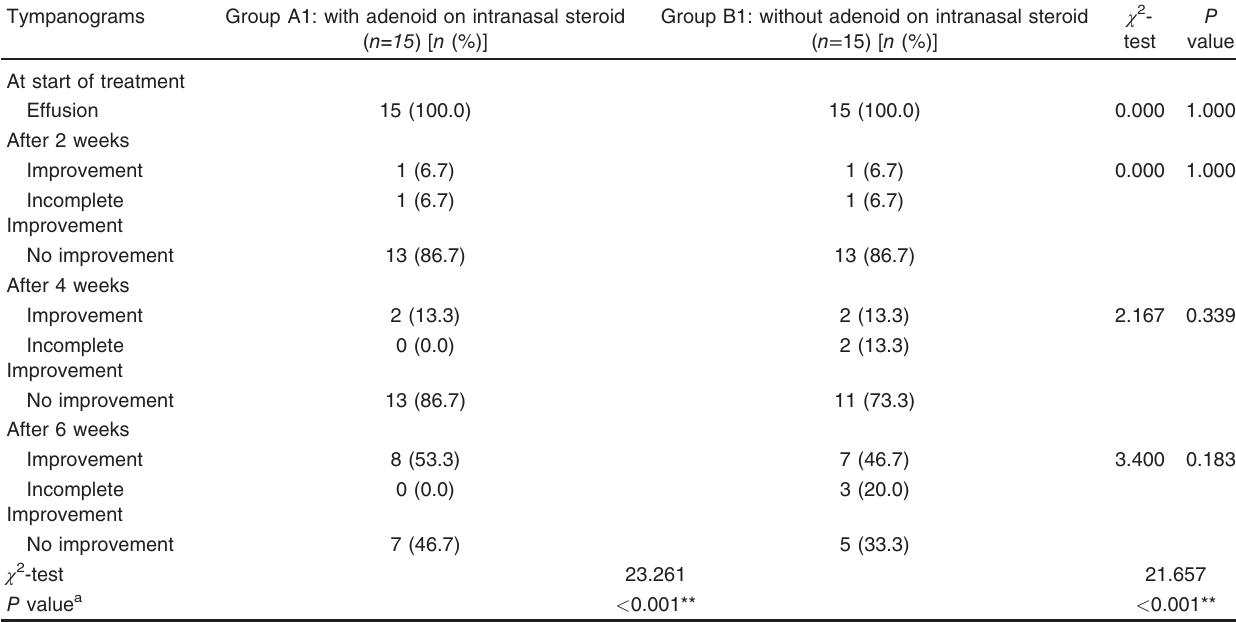
Table 9 Comparison between group A1, with adenoid on intranasal steroid, and group B1, without adenoid on intranasal steroid, according to tympanograms